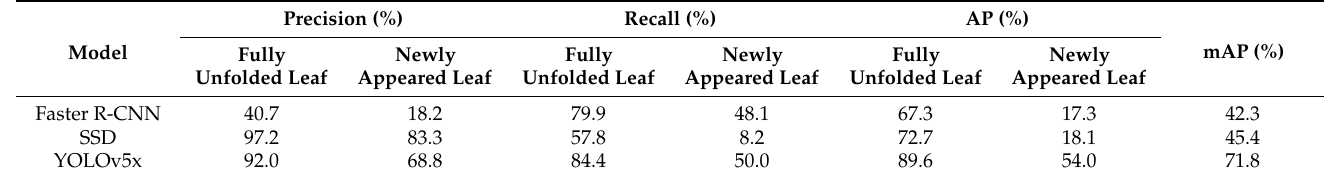
Table 4. Test results of leaf detection with different object detection models.